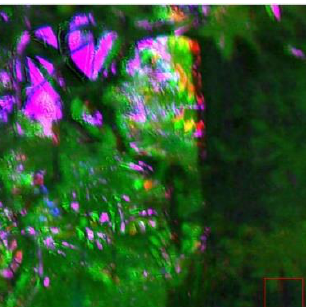
Figure11. Detail of a misaligned caused by parallax